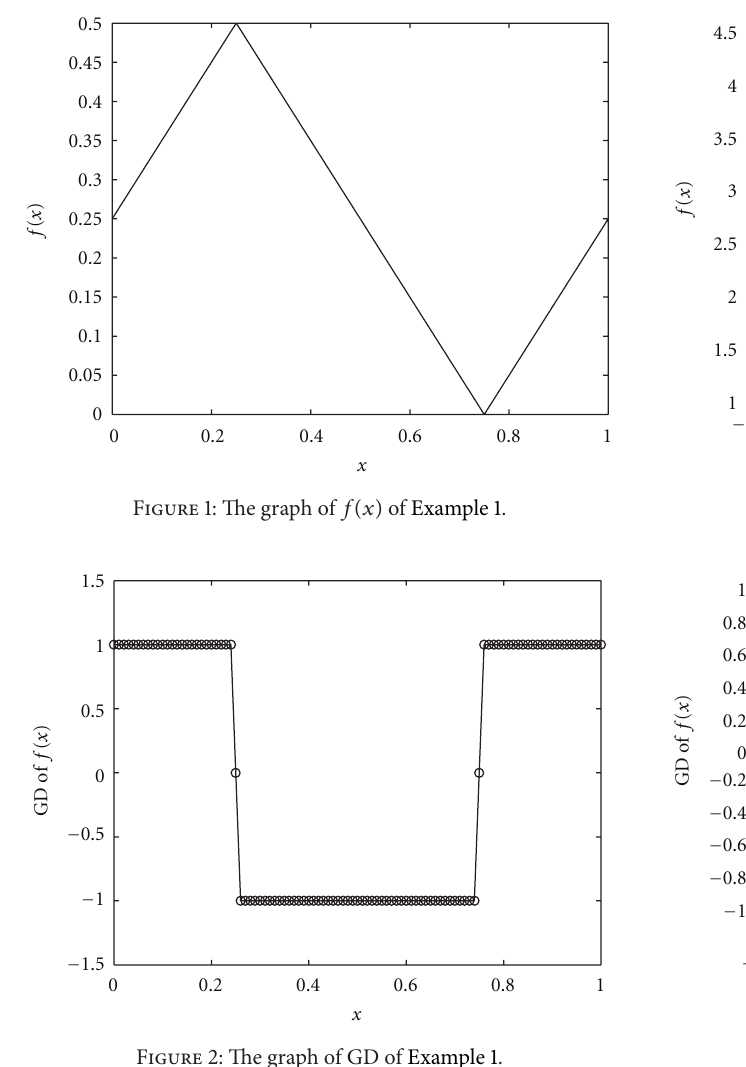
Figure 2: The graph of GD of Example 1.